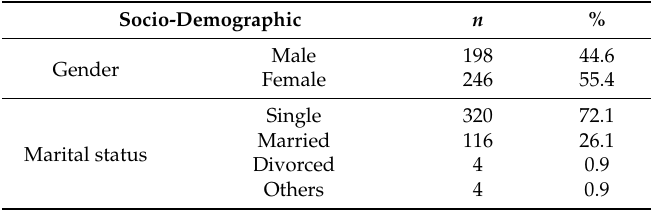
Table 1. Socio-demographic characteristics of respondents ( n =